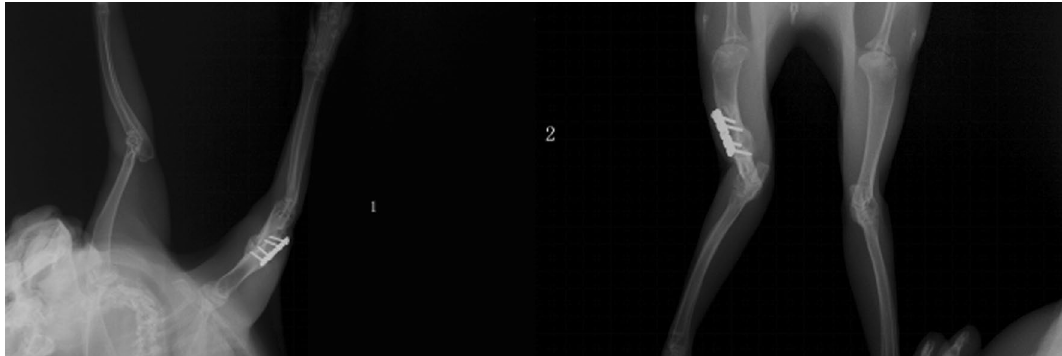
Figure 2. Postoperative X-ray analysis to confirm bone healing.